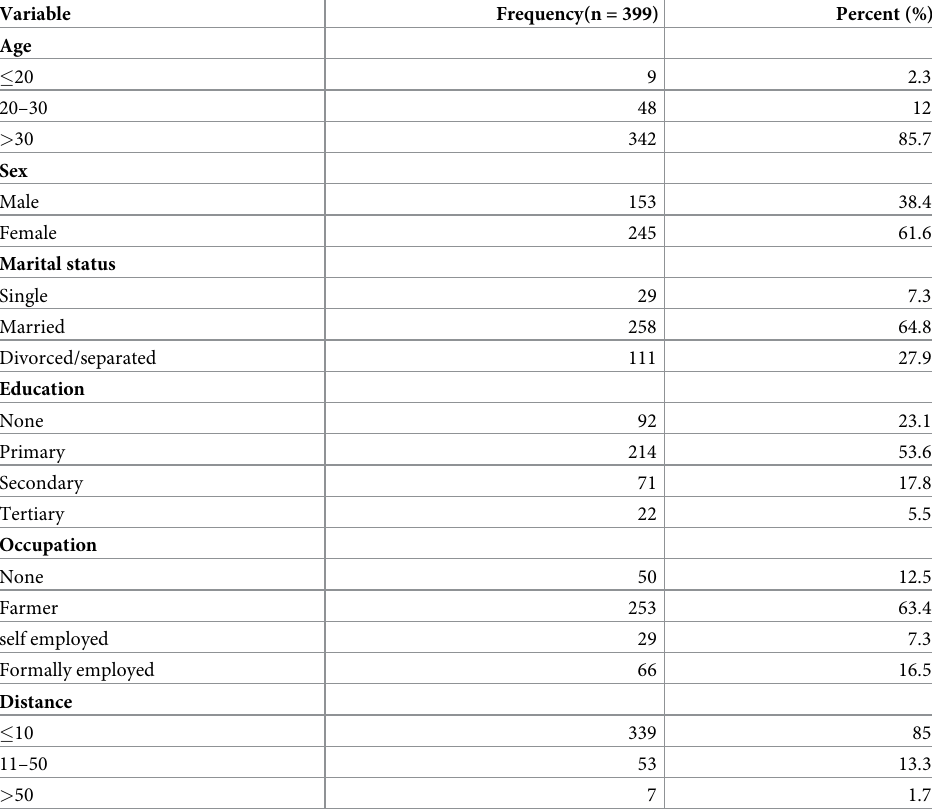
Table 1. Participants social demographic